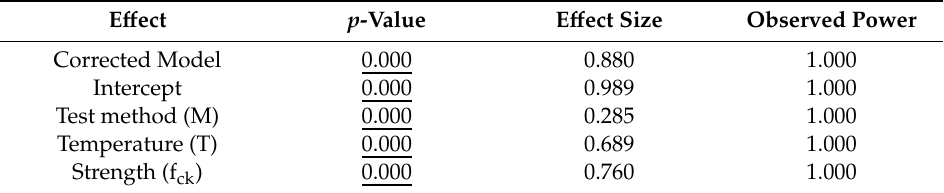
Table 4. Results of the statistical